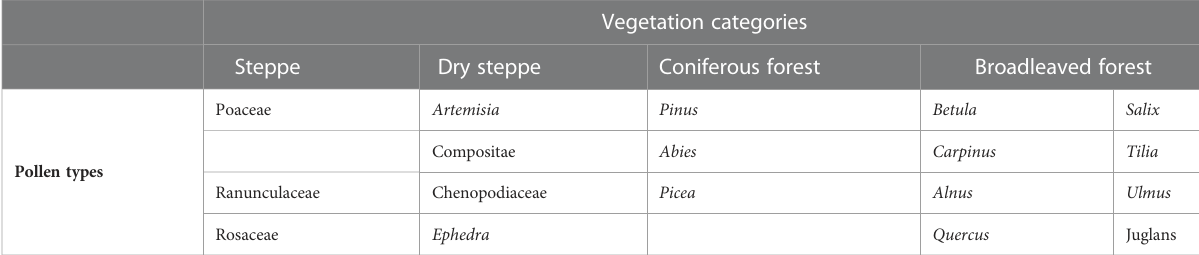
TABLE 4 Classi fi cation of the pollen types into vegetation